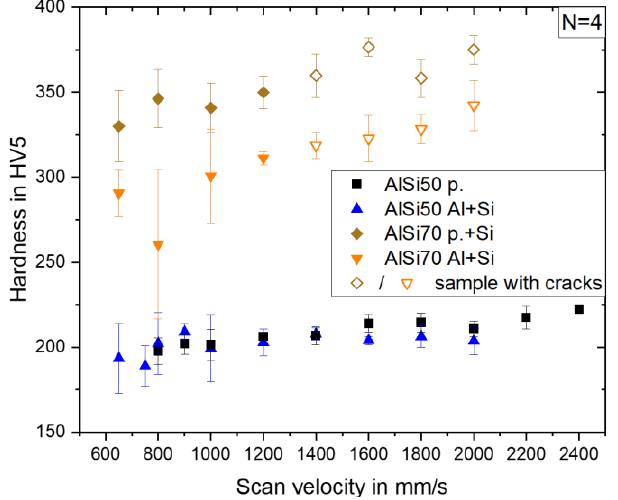
Figure 6. Vickers hardness vs. scan velocity for all AlSi50 and AlSi70 material variants.